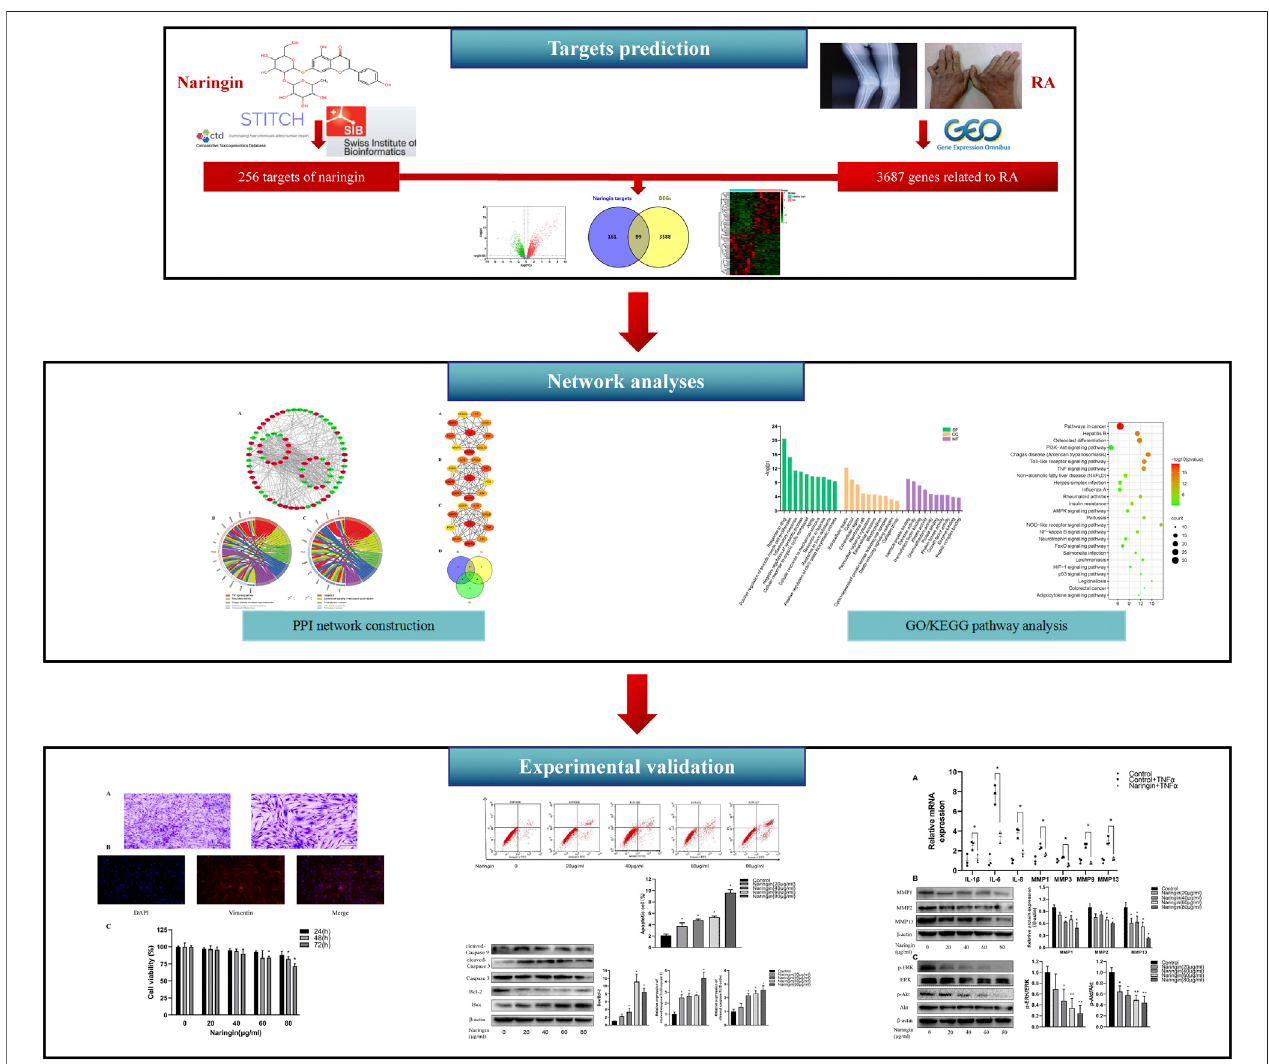
FIGURE 1 | Technical strategy of the current